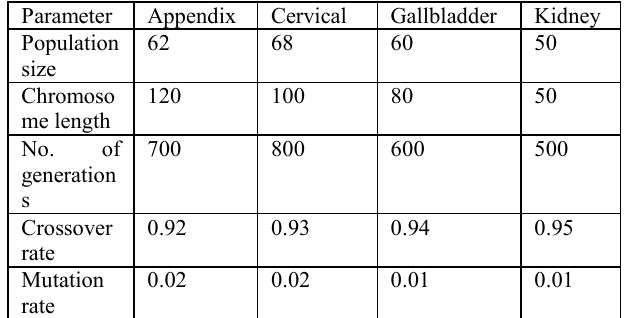
Table 5. MPG with SVM performances on